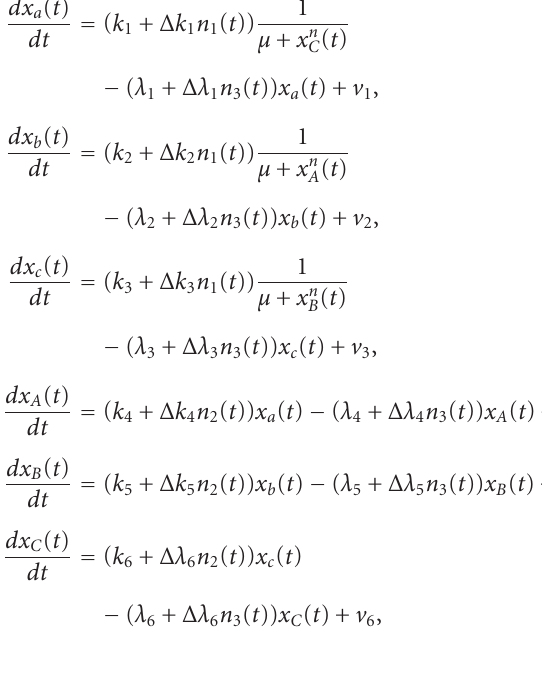
initial state, kinetic parameter fluctuations, and disturbances on the host cell. On the contrary, as shown in Figure 6(b), if the design parameters are selected aside the optimal design parameter k ∗ , for example, with k 1 = 0 . 9, k 2 = 0 . 6, k 3 = 0 . 95, k 4 = 0 . 25, k 5 = 0 . 00002, k 6 = 0 . 6, and k 7 = 0 .